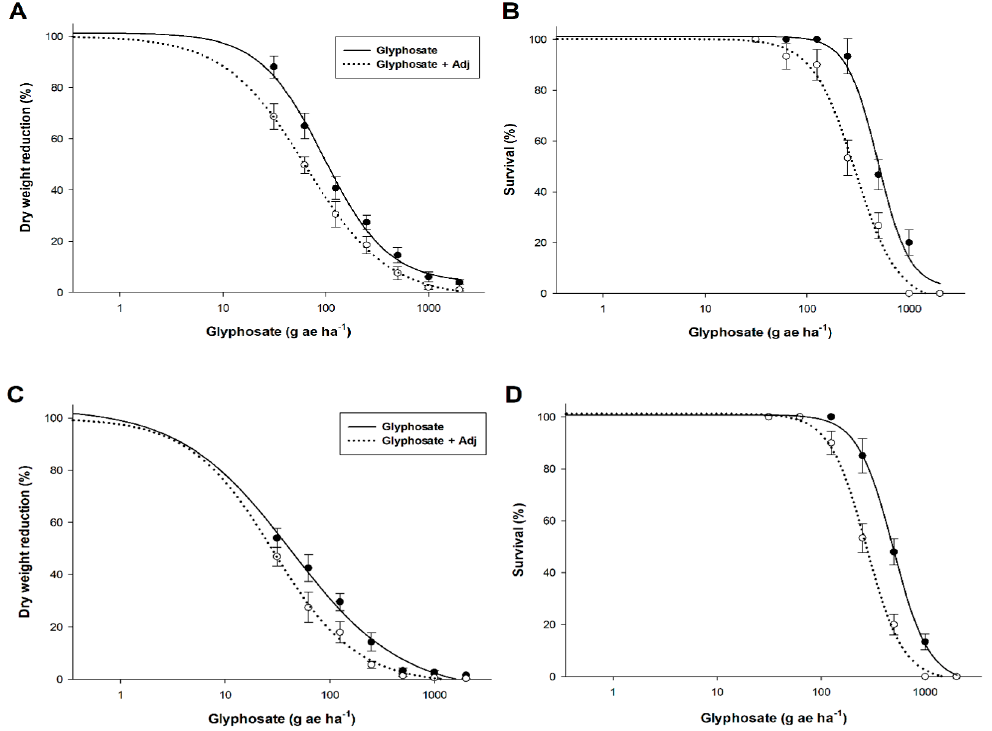
Figure 1. Glyphosate dose response in dry weight reduction and survival expressed as a percentage of the mean untreated control of C. canadensis ( A and B ) and L. rigidum ( C and D ). Table 2. Spray retention and contact angle of glyphosate solution for C. canadensis and L. rigidum